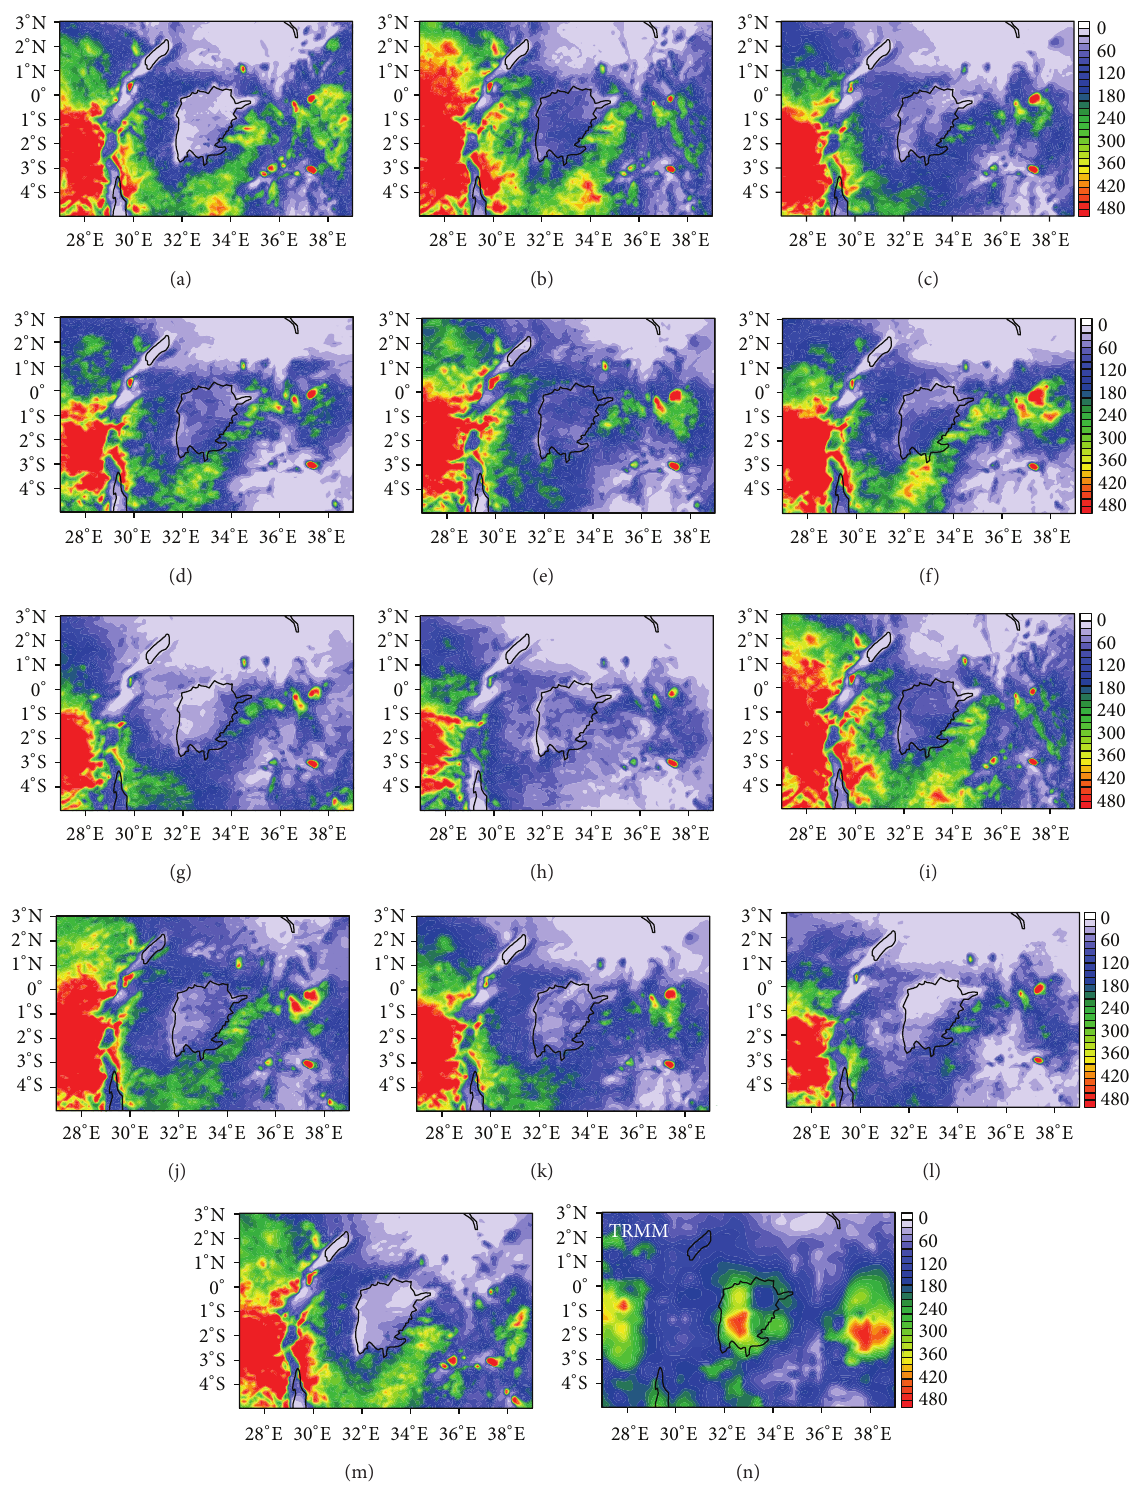
Figure 4: Total November simulated rainfall (mm) over the lake domain for the different physics options (a–m) and TRMM observations for comparison (n). Note the lack of rainfall over western side of the lake in each